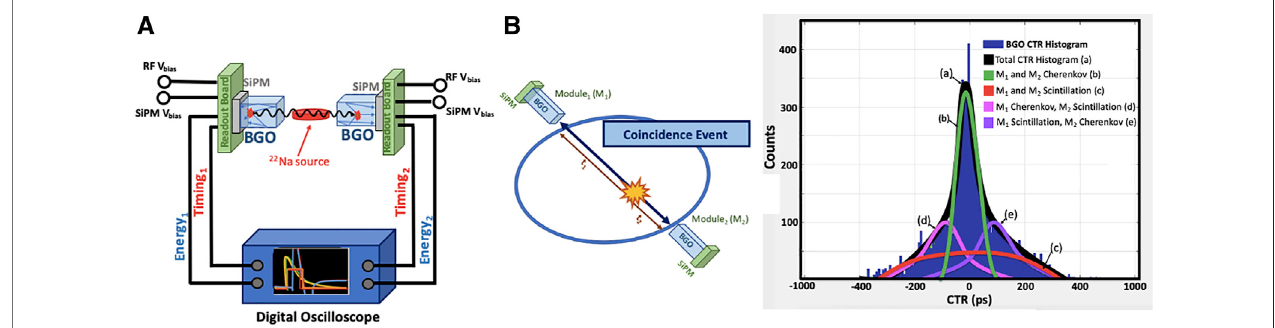
FIGURE 3 | (A) . Scheme of the experimental setup (based on 3.14 × 3.14 mm 2 ) used to collect coincidence data. (B) . Representative sketch of the typical coincidence time spectrum obtained for BGO scintillators showing all the different contributions (M 1 = detector module 1 and M 2 = detector module